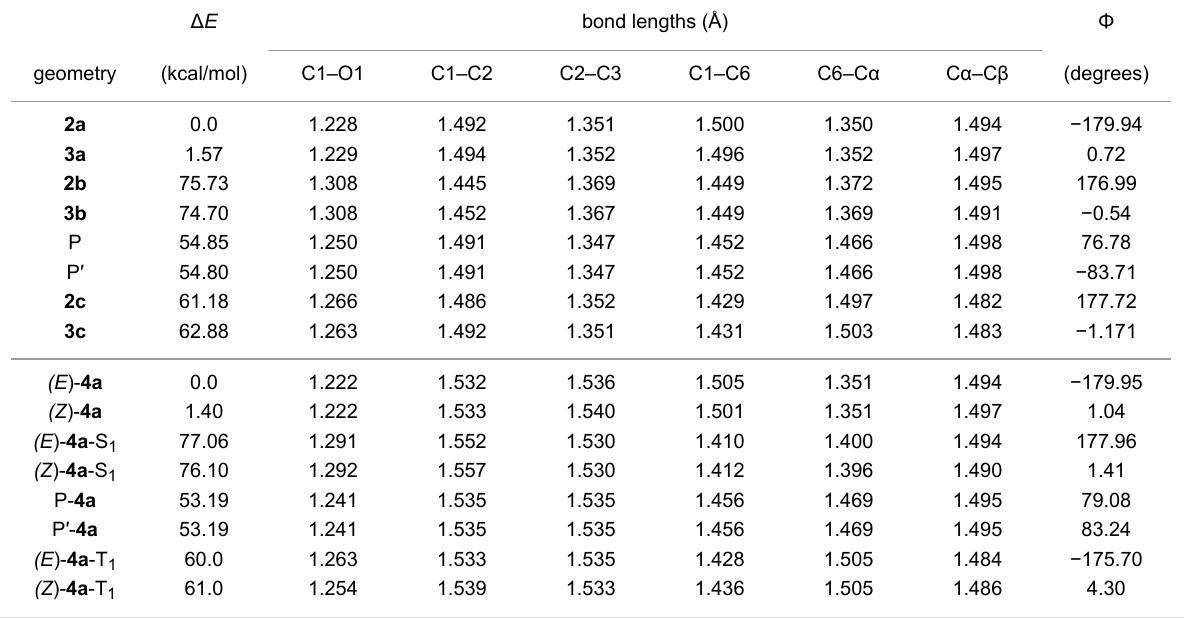
Table 2: Relative energies and selected geometrical parameters of key stationary points in S 0 , S 1 , and T 1 potential energy surfaces of 2a / 3a and 4a